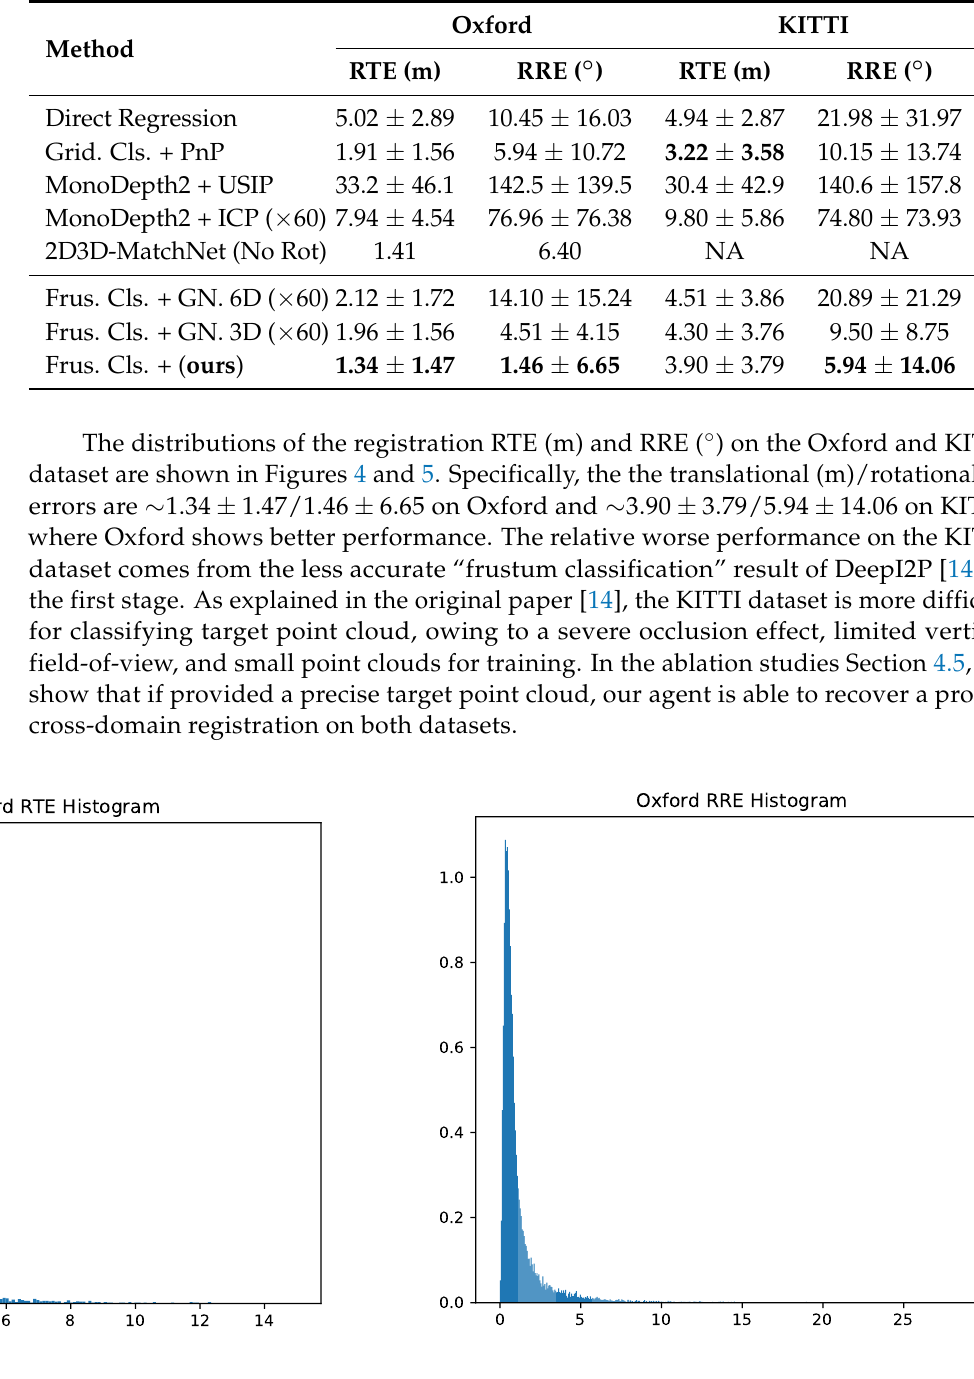
Figure 4. Histograms of image-point cloud registration RTE and RRE on the Oxford datasets. The x-axis is RTE (m) and RRE ( ◦ ), and the y-axis is the